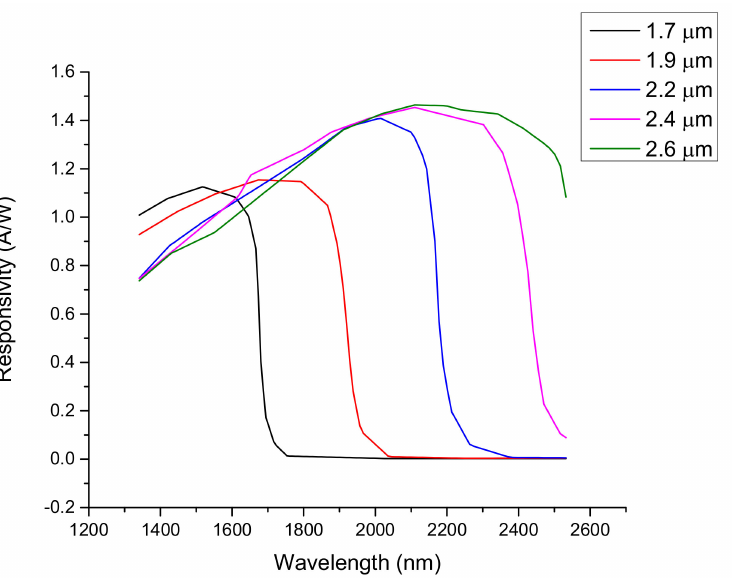
Figure 3. Typical spectral response of the InGaAs sensors available on the market. Each curve is labeled with the cut wavelength of the